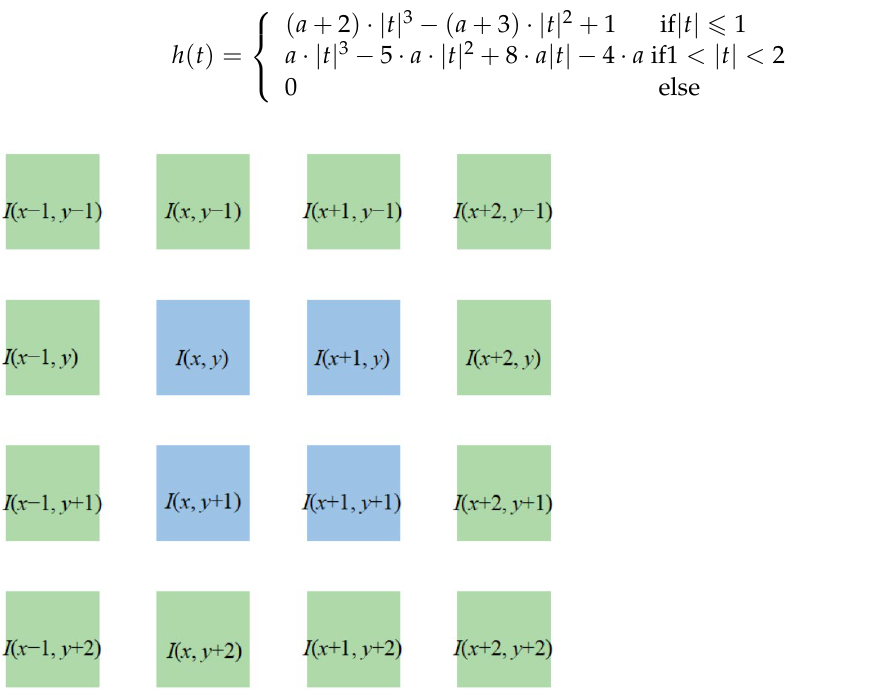
( a ) ( b ) Figure 6. Contour jaggedness error. ( a ) Ideal boundary contour; ( b ) True boundary contour. The impact of the jagged contour on segmentation point detection is mainly at- tributed to two aspects: on one hand, the jagged contour causes noise-like effects that lead to the formation of pseudo-segmentation points; on the other hand, some local features of